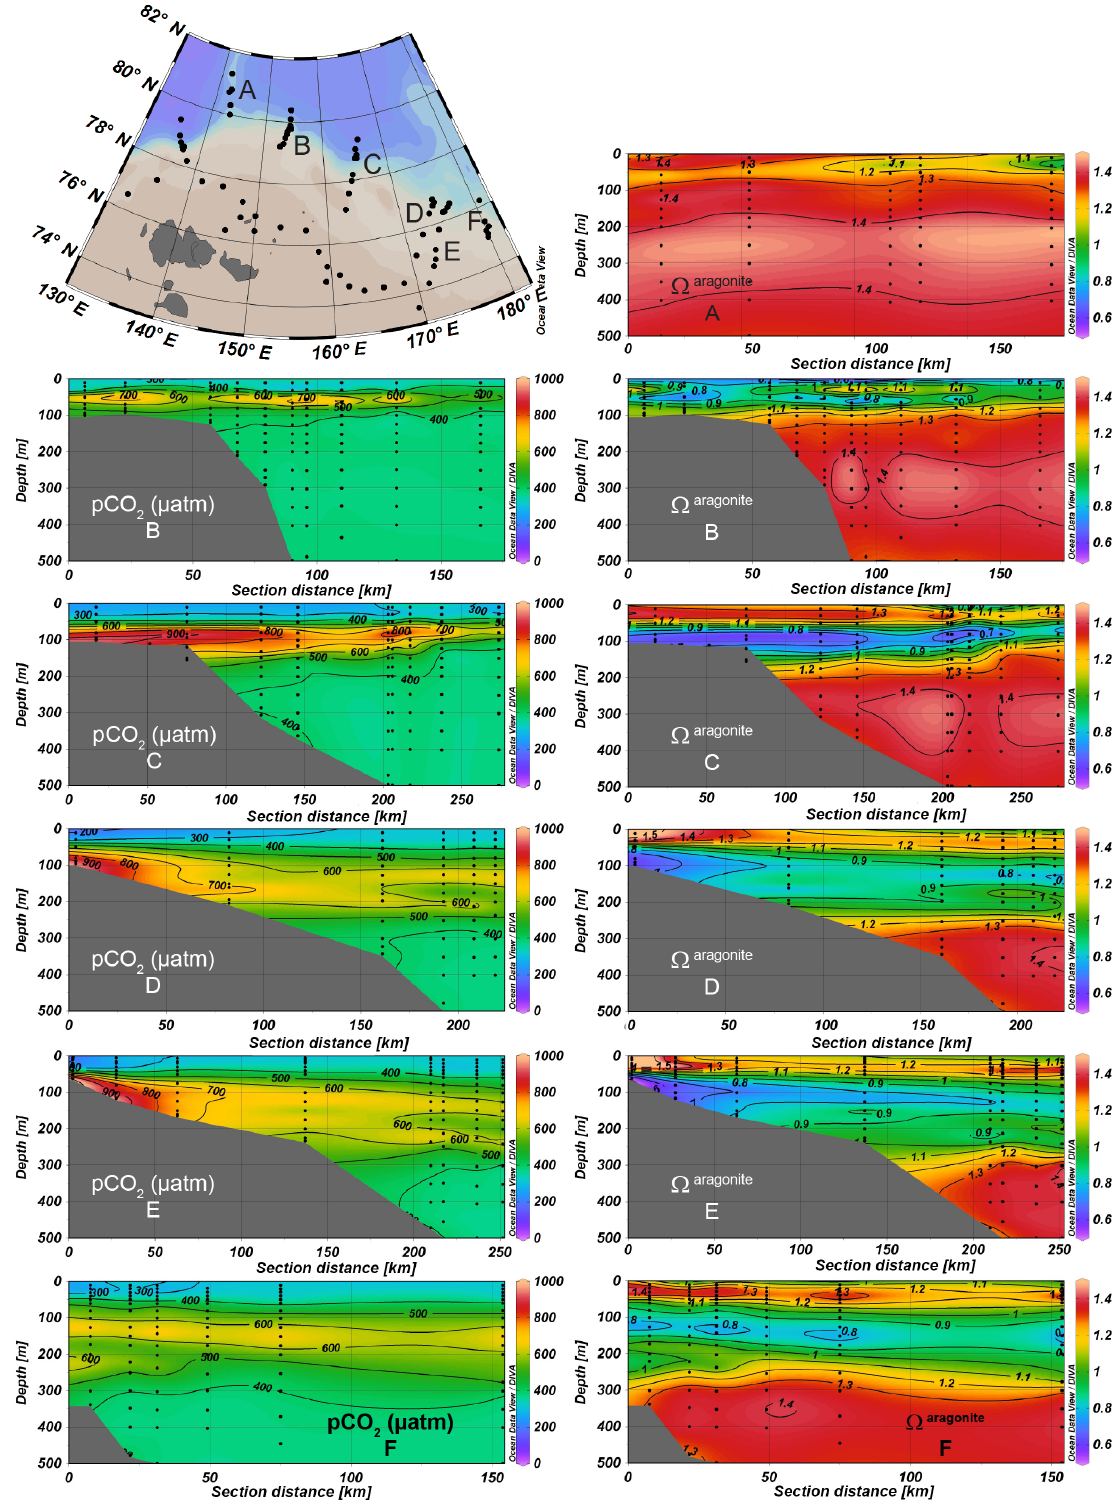
Figure 3. Sections A to F across the East Siberian shelf break, partial pressure of carbon dioxide ( p CO 2 ) to the left and saturation state of aragonite ( (cid:127) aragonite ) to the right. On all sections the colour scale is from 0 to 1000µatm for p CO 2 and 0.5 to 1.5 for (cid:127) aragonite . Note the variable horizontal extent of the different sections. The locations of the sections are noted on the inserted